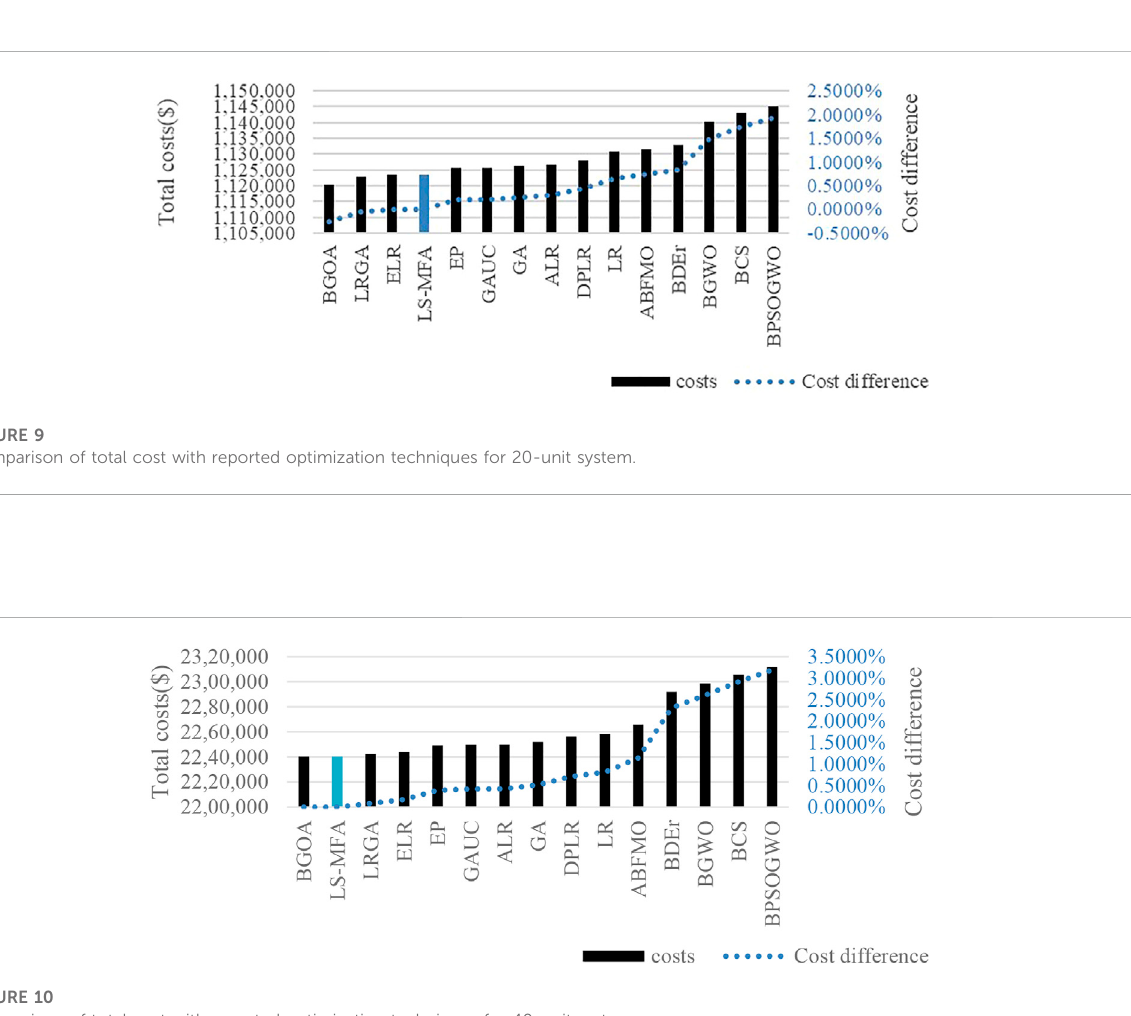
FIGURE 10 Comparison of total cost with reported optimization techniques for 40-unit system.